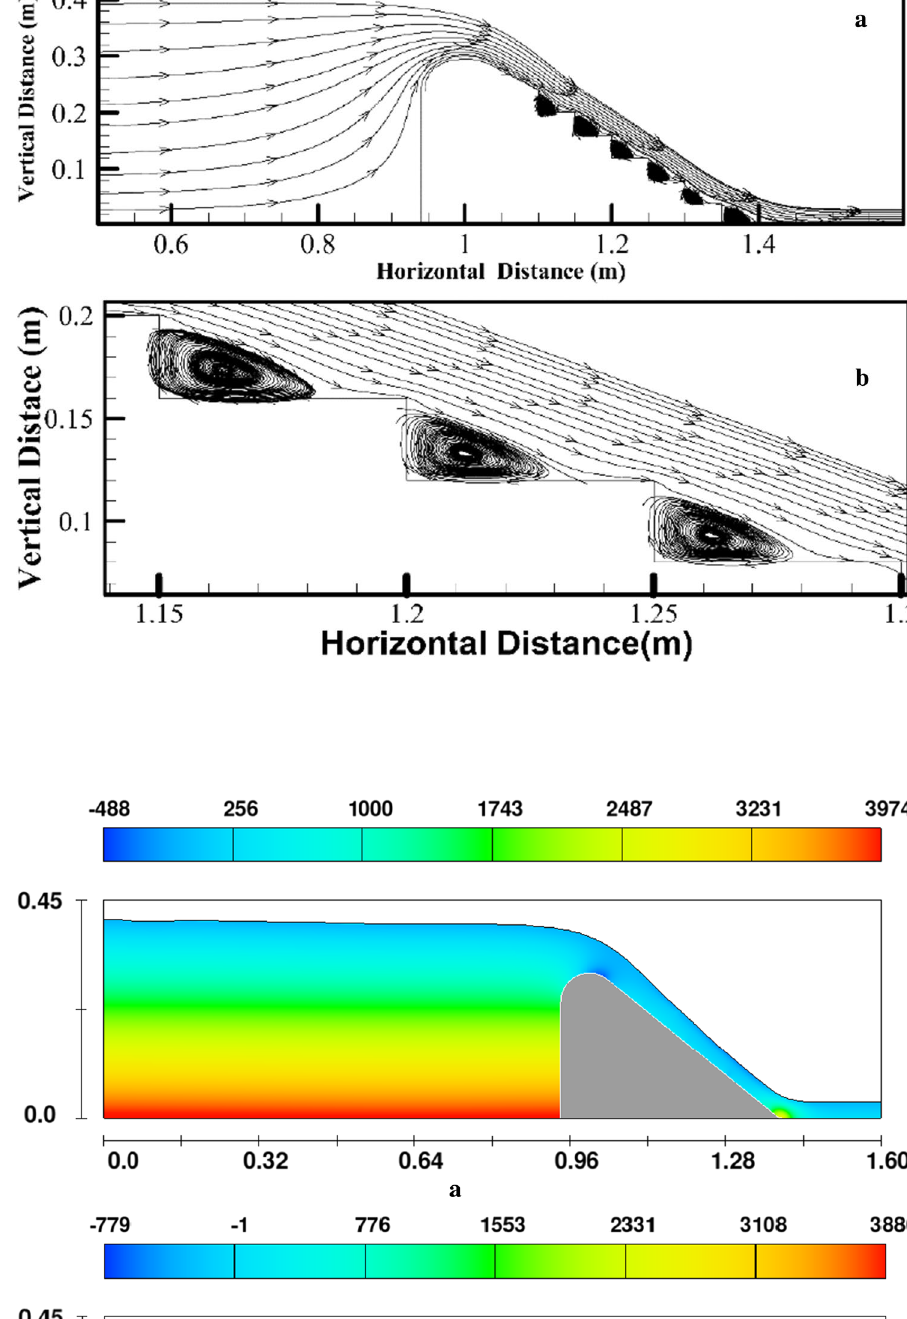
Fig. 5 The streamline and Froude number of flow over the crest ( a ) and chute ( b ) of CCSS